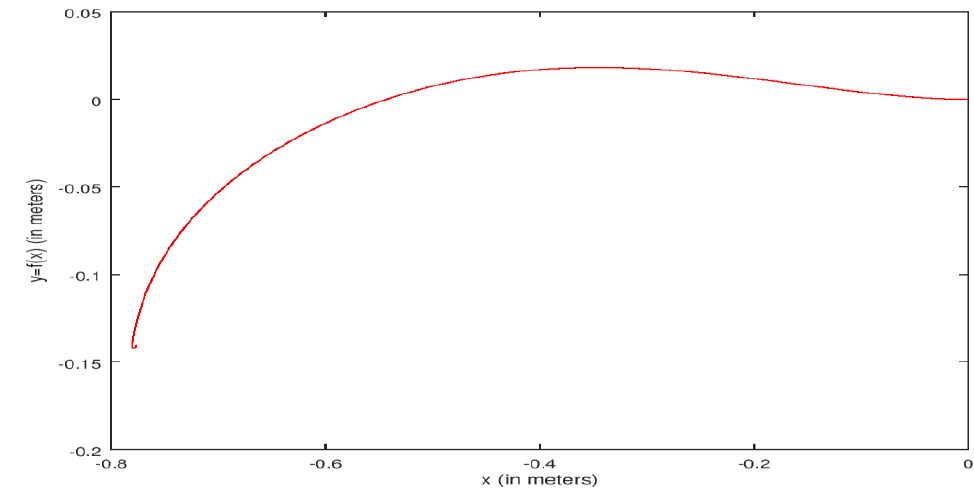
Figure 3. Feasible Vehicle Robot Trajectory (Initial condition = [zeros (7,1); 25 ∗ ones (7,1)]).